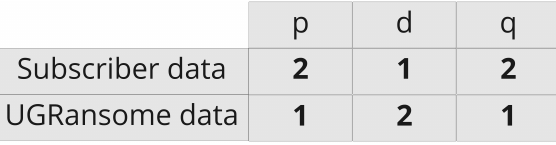
Figure 10. The ARIMA model